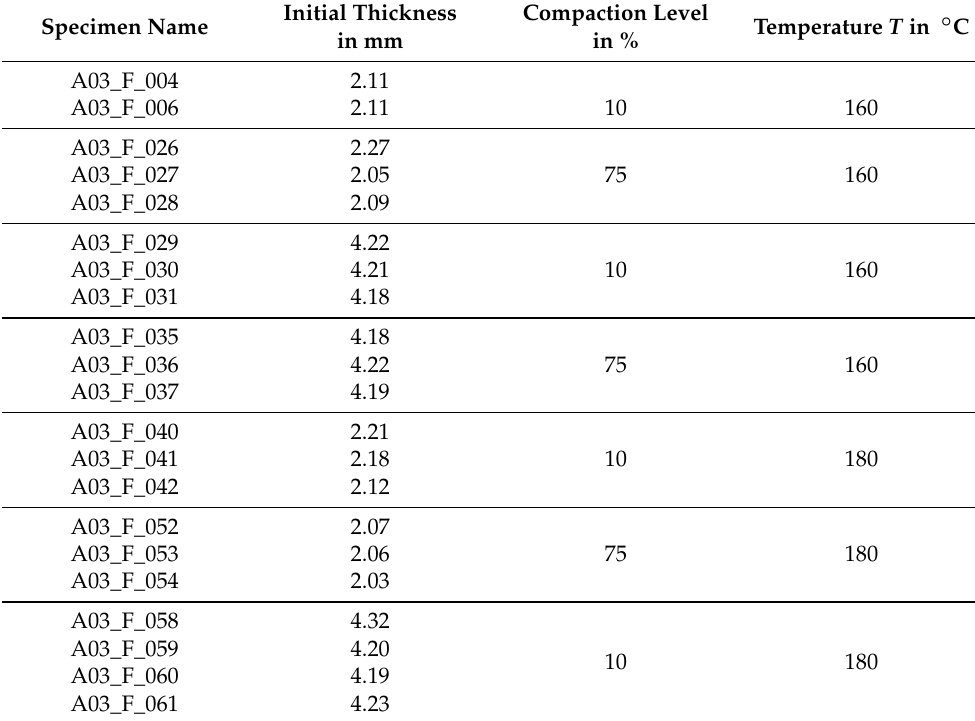
Table A1. Process parameters and initial thickness for every specimen